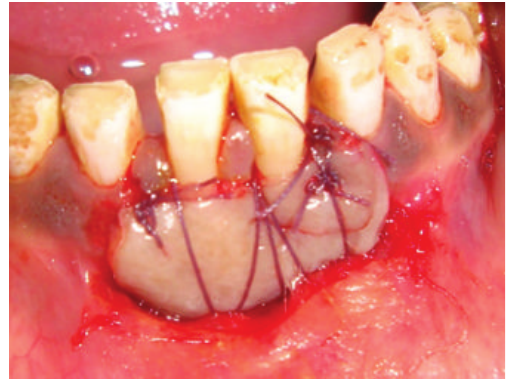
Figure 16: Suturing.